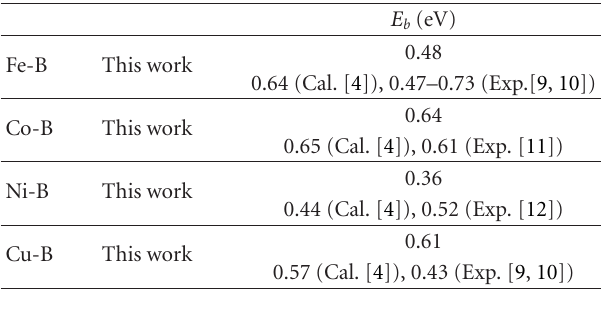
Figure 1: Calculated di ff usion barrier E d of 4th element impurity atoms in Si crystal.